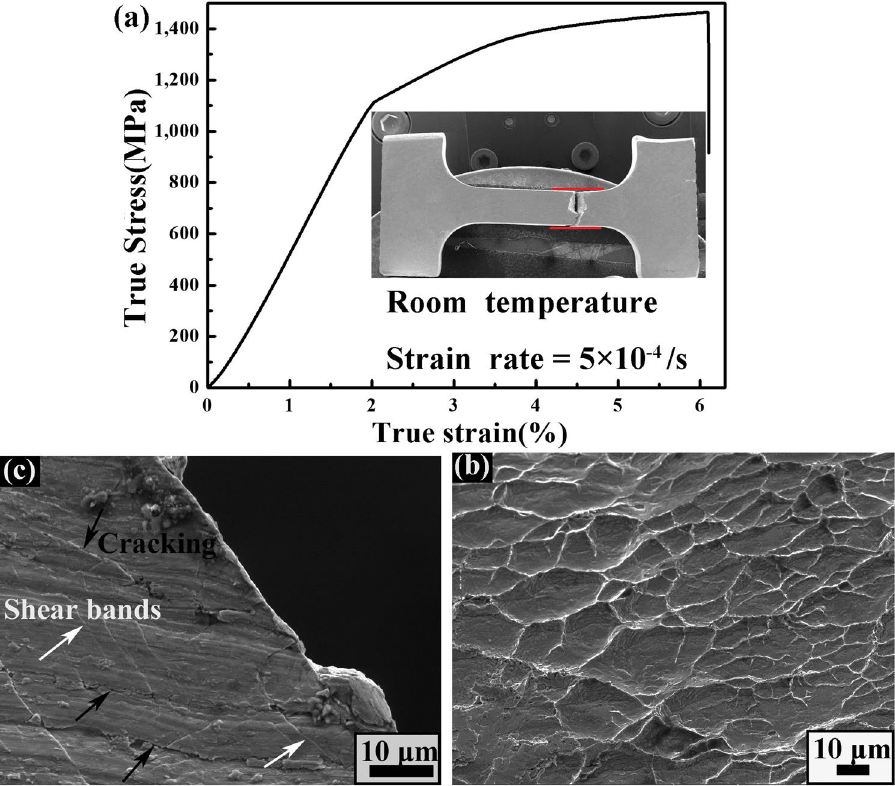
Figure 3. ( a ) Tensile true stress-strain curve of the present Ti-based MGMCs, the inset showing a low- magnification SEM image of the fractured sample and the strain rate of 5 × 10 − 4 s − 1 ; ( b ) Vein patterns showed on fracture surface; and ( c ) the lateral surface after tensile deformation, demonstrating the shear bands and significant cracking, indicated by arrows.